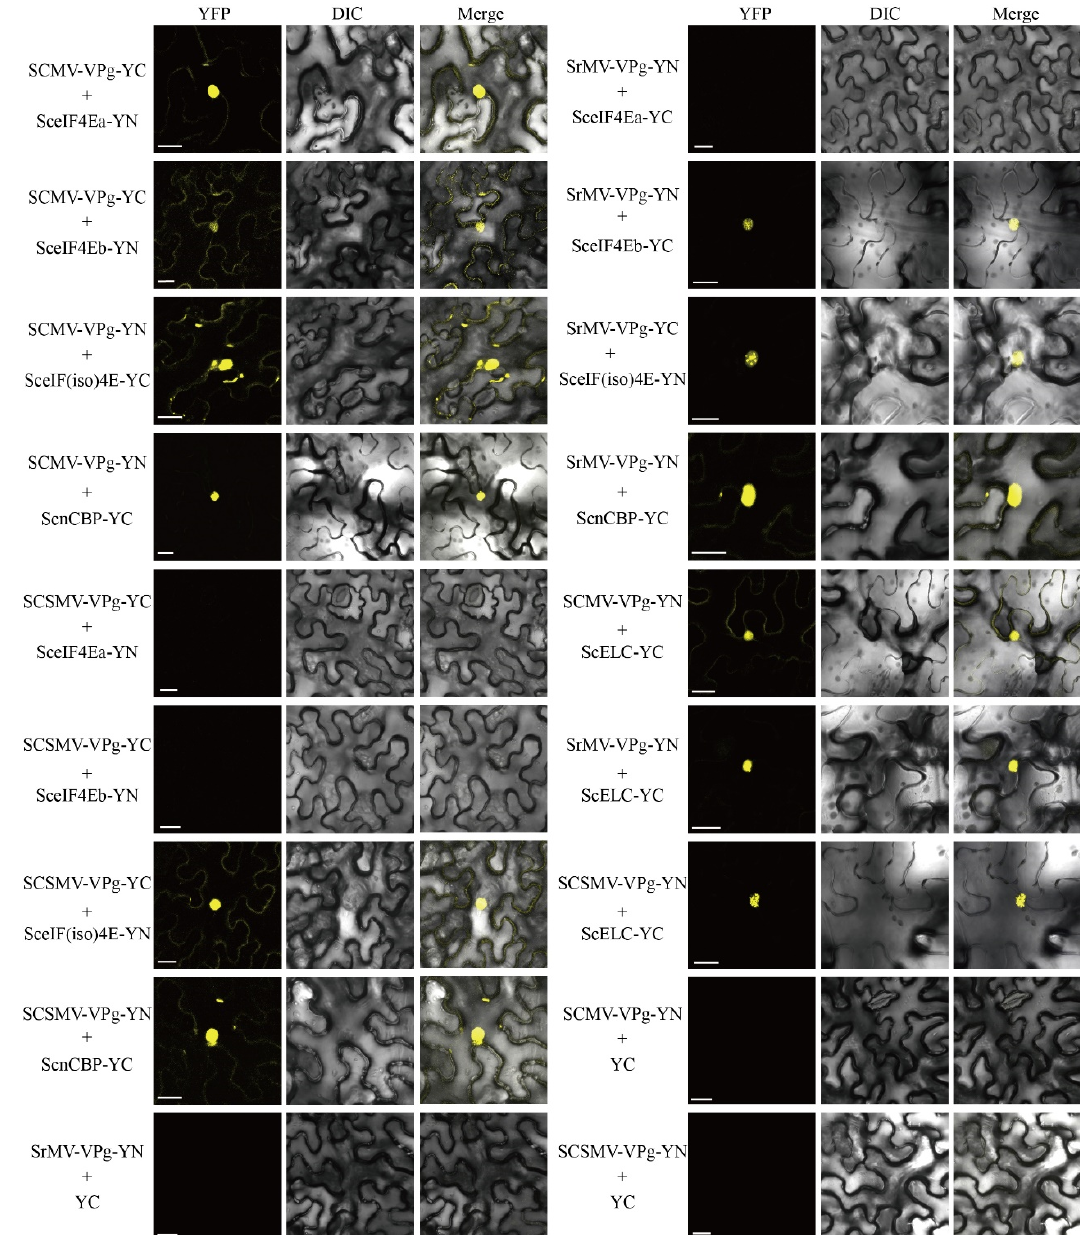
Figure 6. Investigation of protein interaction by bimolecular fluorescence complementation assays. Agrobacteria harboring YC/YN fusion proteins were co-infiltrated into Nicotiana benthamiana leaves, respectively. The leaf epidermal cells pairwise co-transformed with SCMV-VPg-YN, SrMV-VPg-YN or SCSMV-VPg-YN and ScELC-YC were used as positive controls, while SCMV-VPg-YN, SrMV-VPg-YN or SCSMV-VPg-YN and YC were used as negative controls. The images were captured at 48 h post agroinfiltration. Bars = 25 μ m.